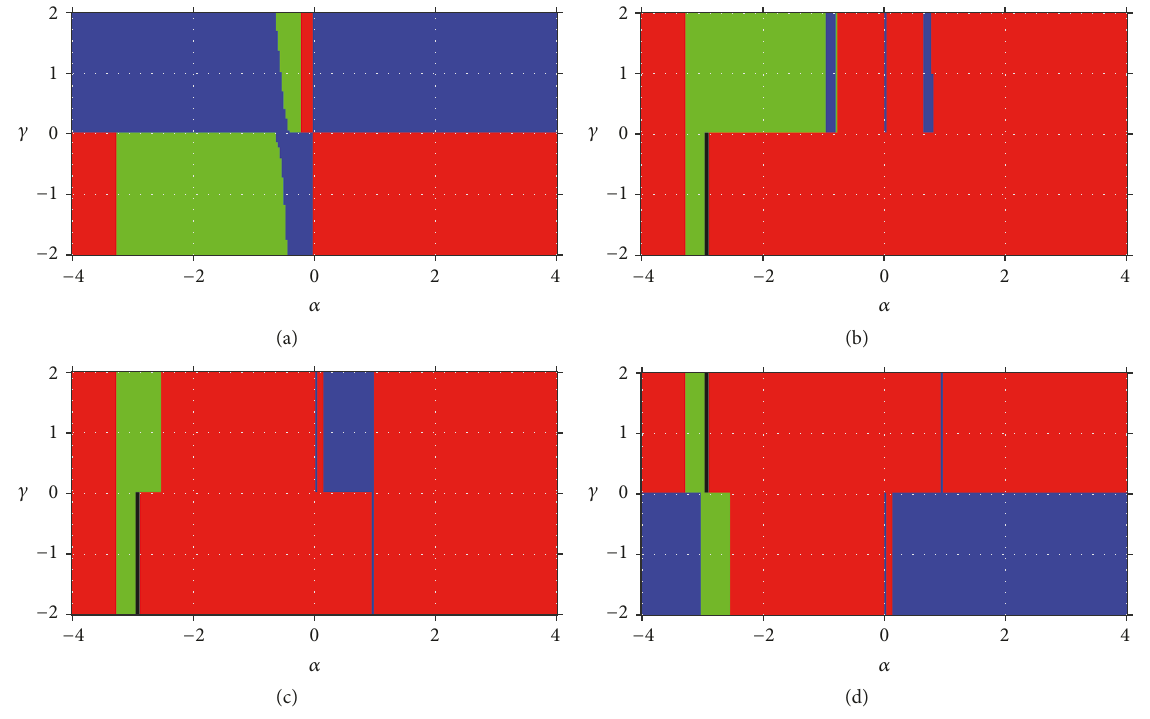
Figure 7: Parameter planes of (a) 𝑥 𝐶 1 , (b) 𝑥 𝐶 2 , (c) 𝑥 𝐶 3 , and (d) 𝑥 𝐶 4 (red: 𝑥 ∗ 1 , green: 𝑥 ∗ 2 , blue: 𝑥 ∗ ∞ , and black: others).